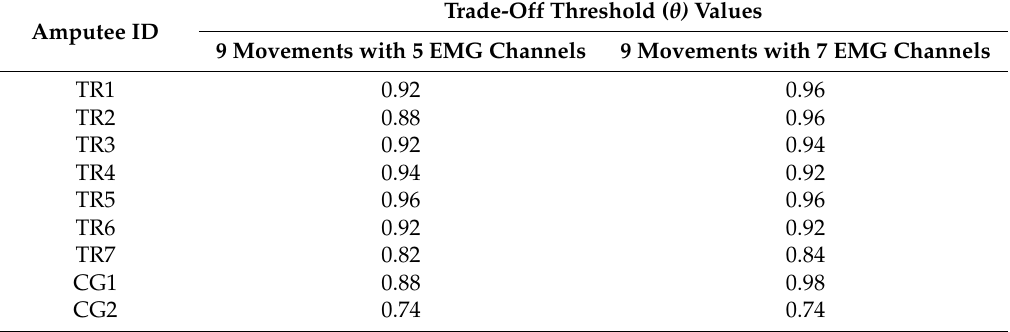
Table 5. Example of threshold values for 9 movements with 5 and 7 EMG channels for nine amputees with TD-PSD FE method.